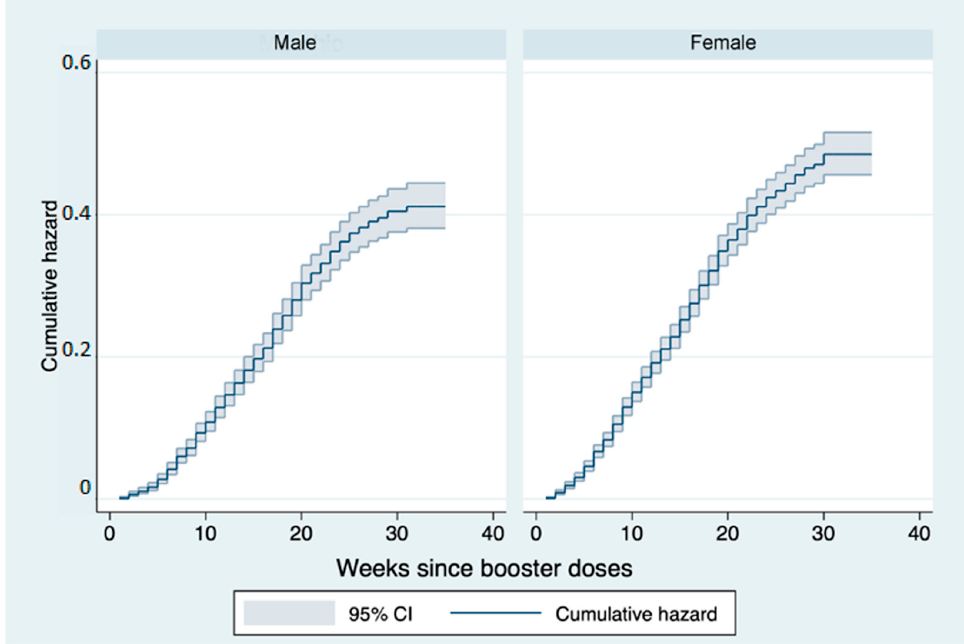
Figure 3. Nelson–Aalen cumulative hazard estimates: curves representing the cumulative risk of infection after booster dose stratified by sex in the follow-up period.